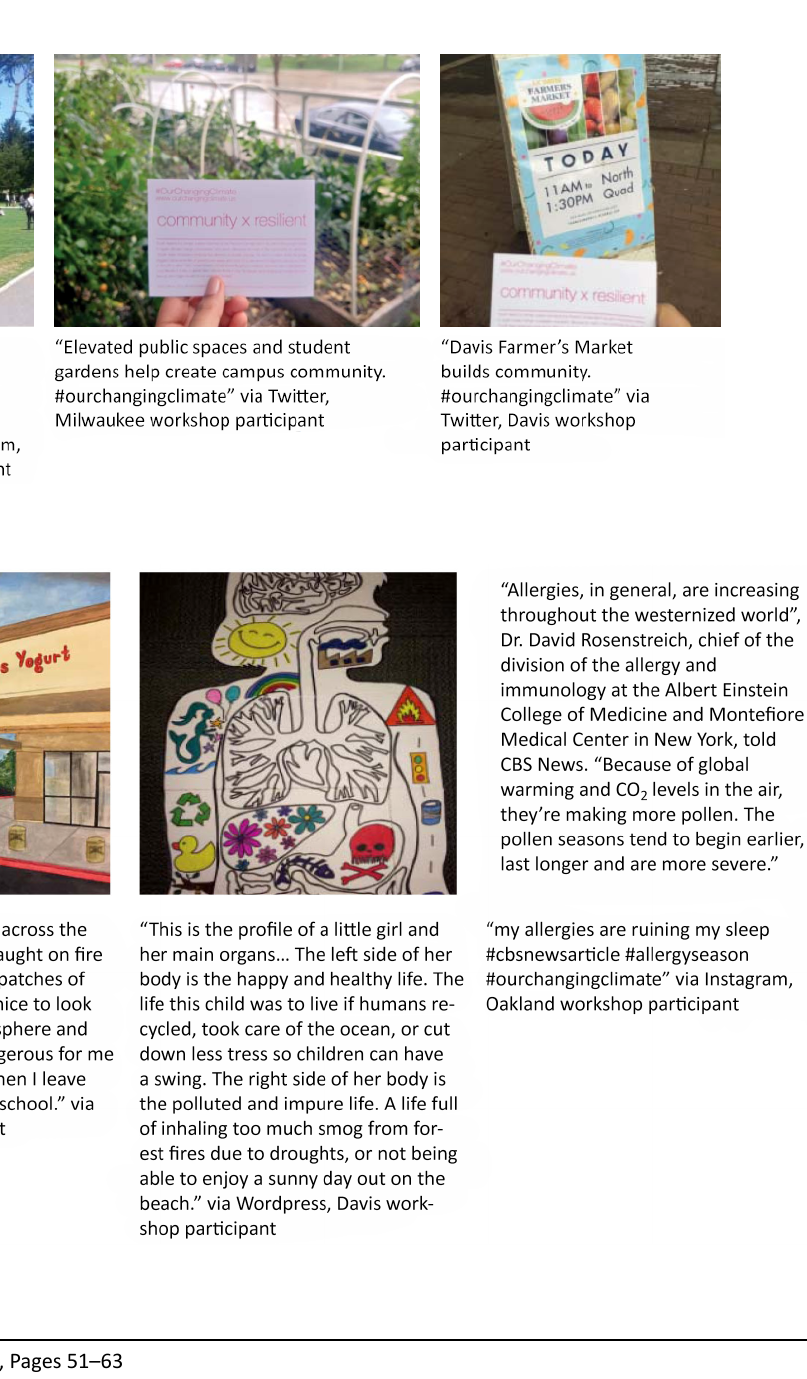
Figure 5. Health-related